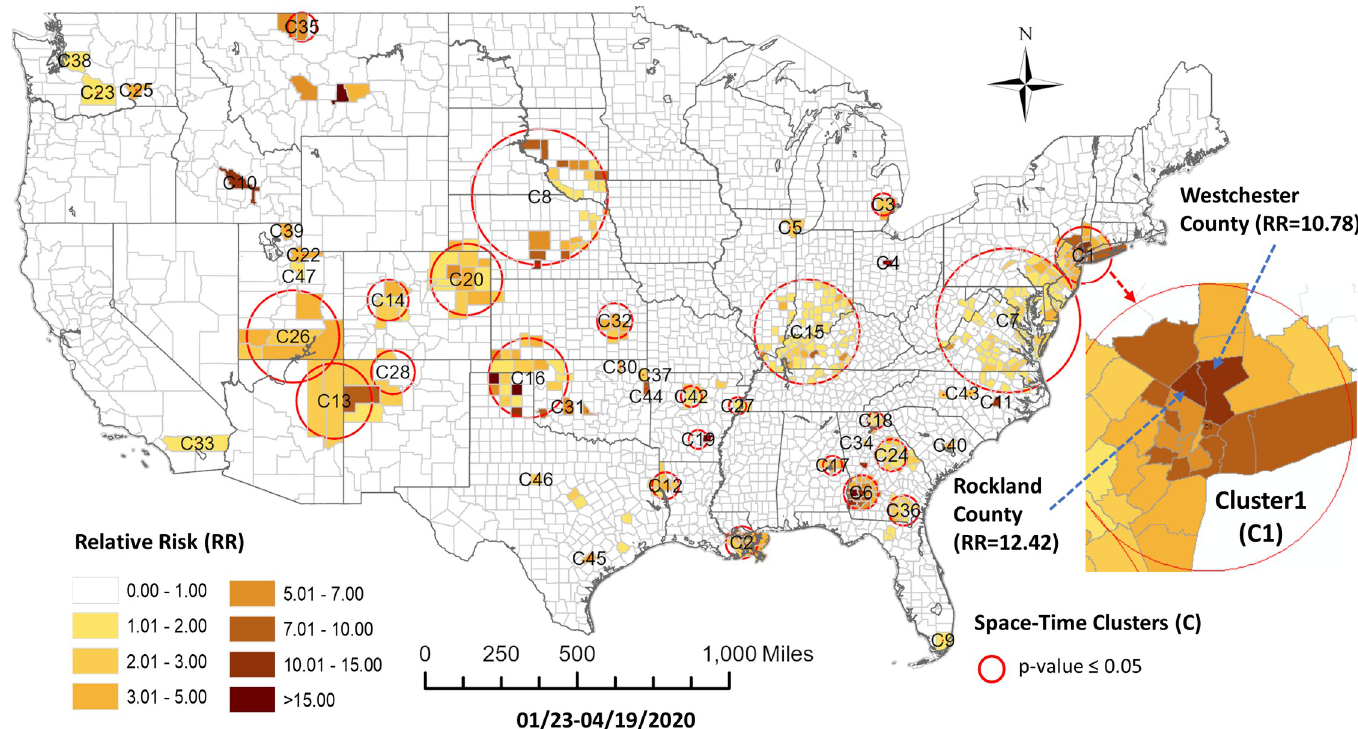
Fig 7. COVID-19 space-time scan statistic detected hotspots in the United States at county level through 4/19/2020.